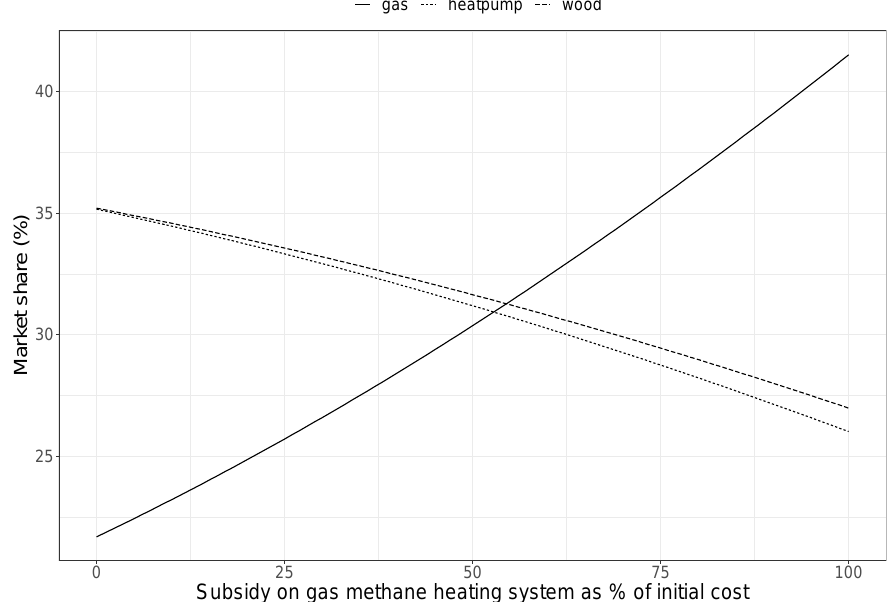
Figure 6. Simulation 1: MNL simulation on market share change providing only a subsidy to natural